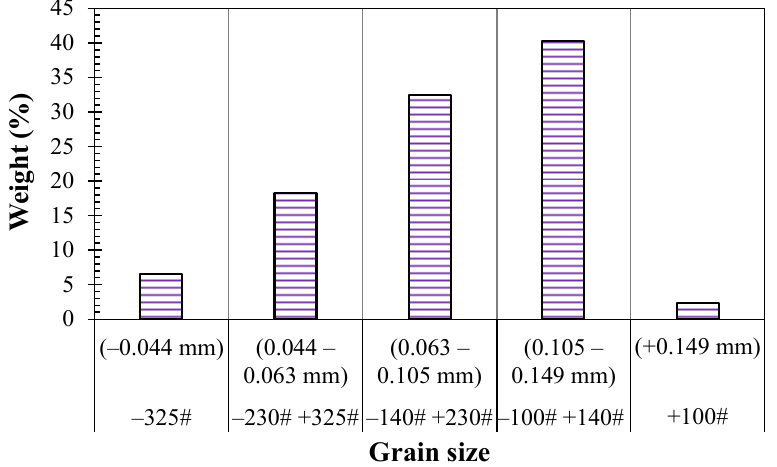
Figure 1. Grain size distribution of ilmenite concentrate. Table 1. Chemical composition of ilmenite concentrate (in wt%).